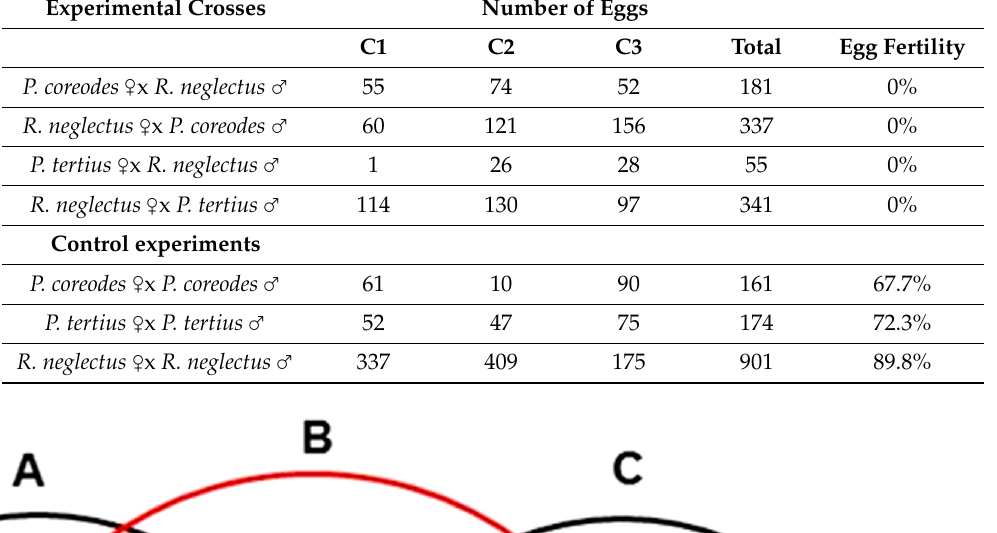
Table 1. Results of the experimental crosses performed between Rhodnius and Psammolestes. Experimental Crosses Number of Eggs